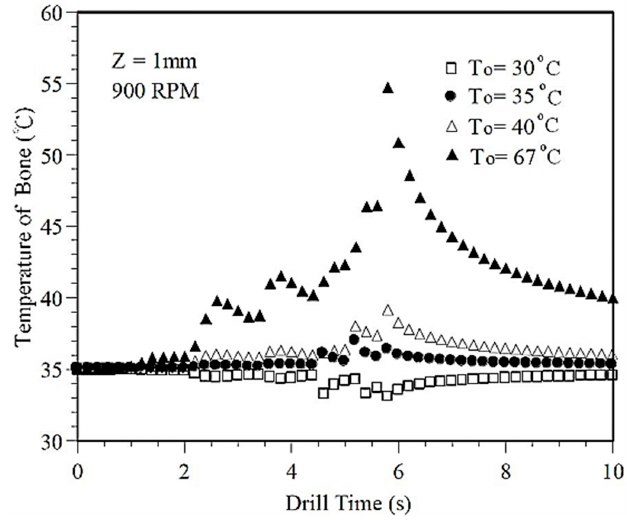
Figure 9. Variation in temperature with the drill time for various initial temperatures [21].